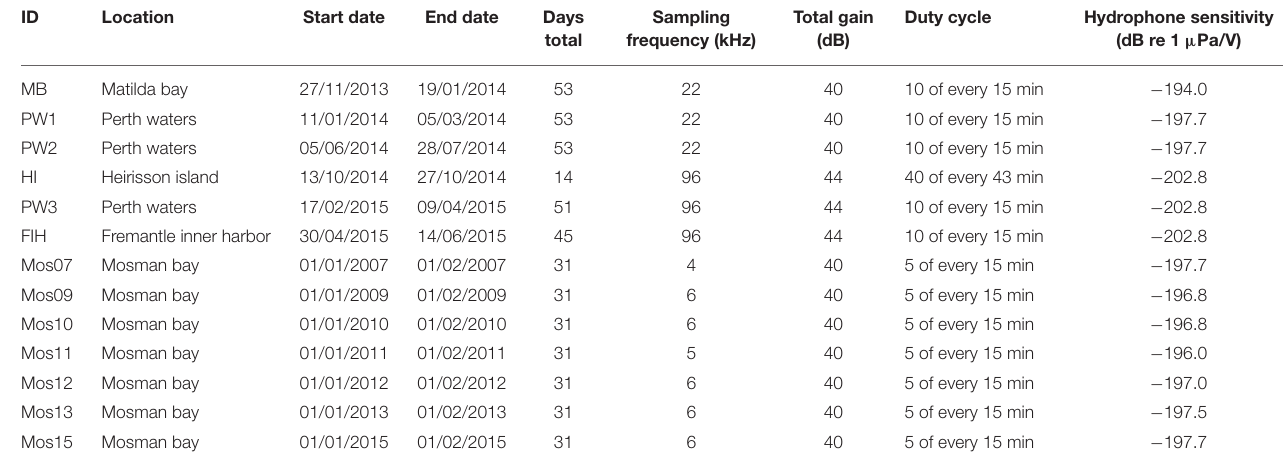
TABLE 1 | Summary of acoustic data collection within the Swan